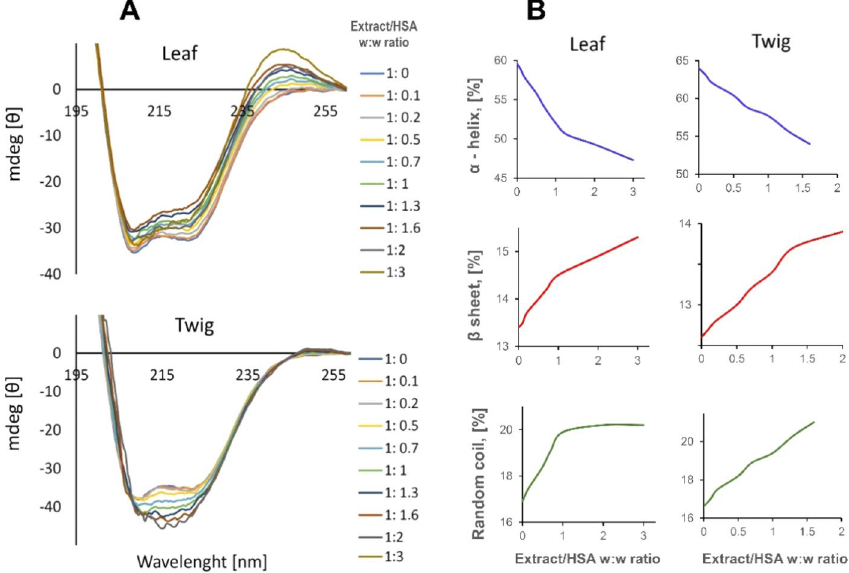
Figure 5. ( A ) Ellipticity changes and ( B ) changes in the secondary structure of HSA at the presence of varying ratios of the Hippophae rhamnoides L. leaf and twig extracts. HSA concentration 1